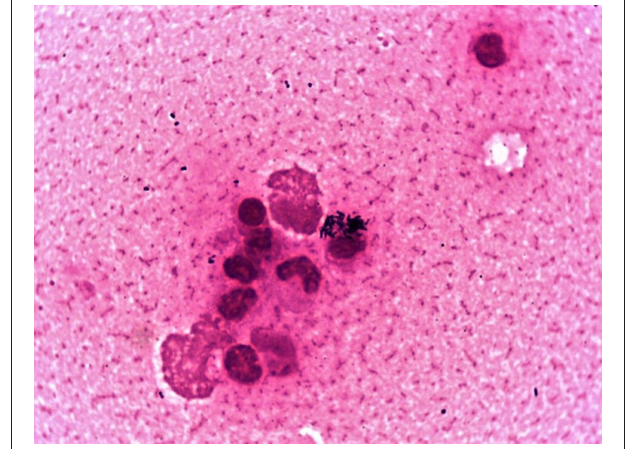
FIGURE 1 | Gram-stained smear of the horse’s nasal exudate showing numerous intracellular C. ulcerans with lesser amounts of Streptococcus zooepidemicus .